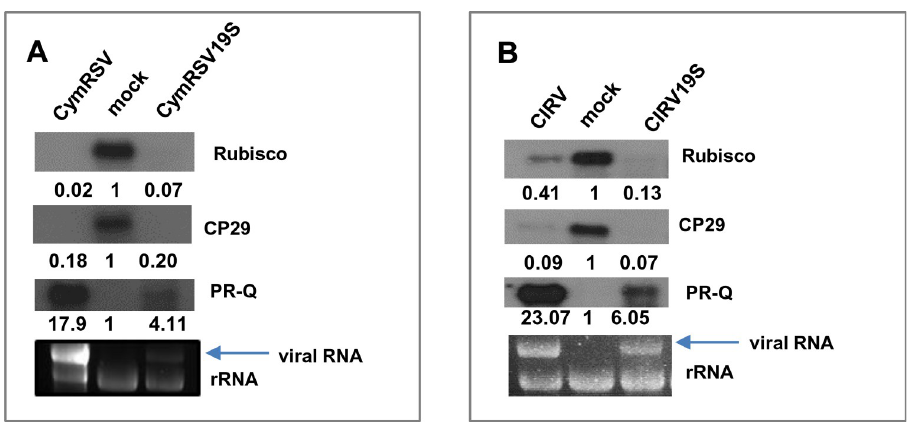
Fig 9. Northern blot analysis of the gene expression changes in N . benthamiana plants infected with wild-type and VSR mutant viruses at 15˚C. N . benthamiana plants were infected with CymRSV or CymRSV19S (A) and CIRV or CIRV19S viruses (B). Accumulation of Rubisco, CP29 and PR-Q mRNA was investigated in systemically infected leaves at 12 dpi by Northern blot analysis. Fold-change values are shown below each band (quantifications were normalized to mock controls). EtBr-stained agarose gel served as a loading